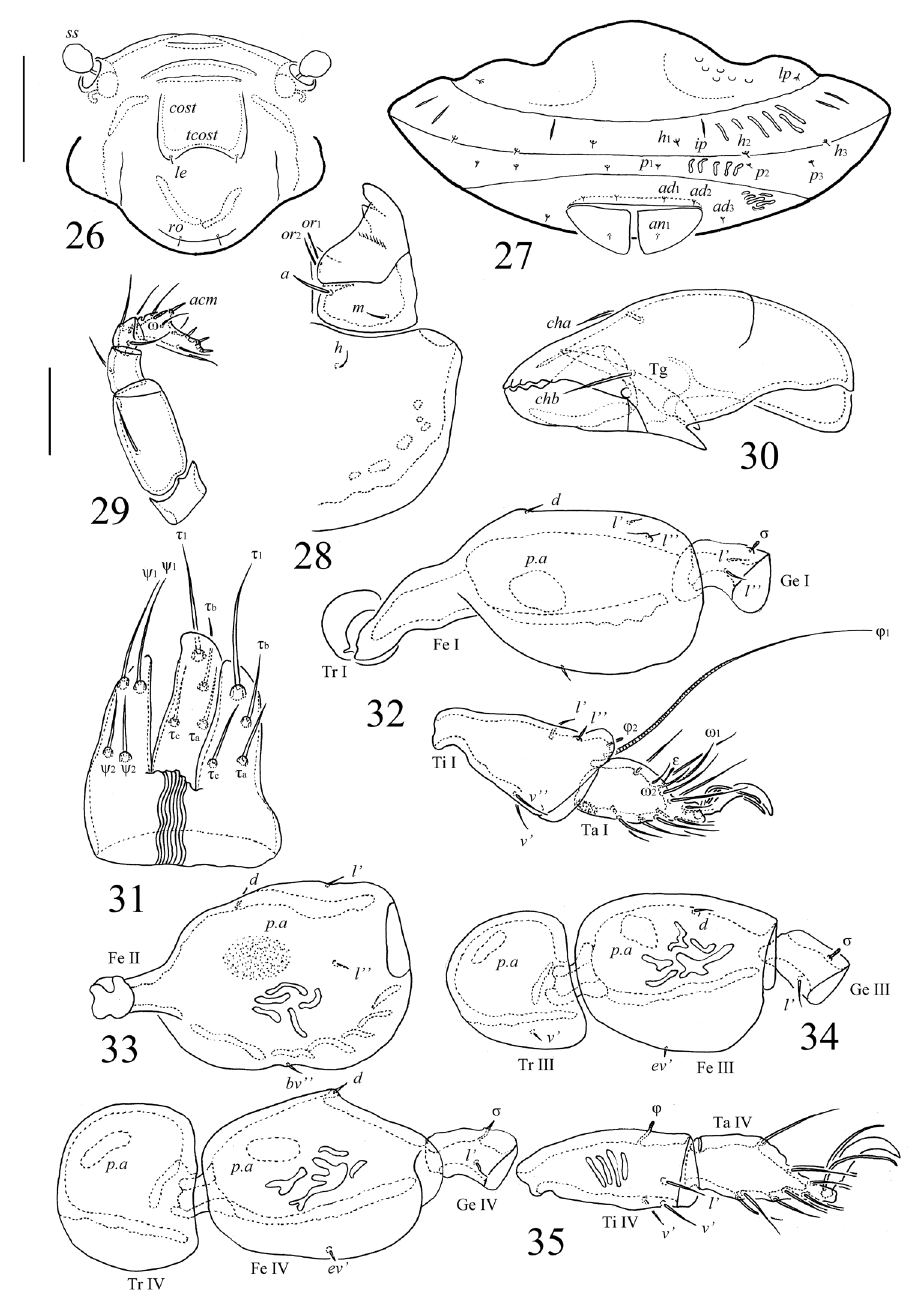
Figures 26–35. Scapheremaeus luxtoni sp. n., adult: 26 frontal view of prodorsum 27 posterior view 28 subcapitulum 29 palp 30 chelicera, antiaxial view 31 ovipositor 32 leg I, right, antiaxial view 33 fe- mur of leg II, left, paraxial view 34 trochanter, femur and genu of leg III, left, antiaxial view 35 leg IV, left, antiaxial view. Scale bars 50 µm ( 26, 27 ), 20 µm ( 28–35